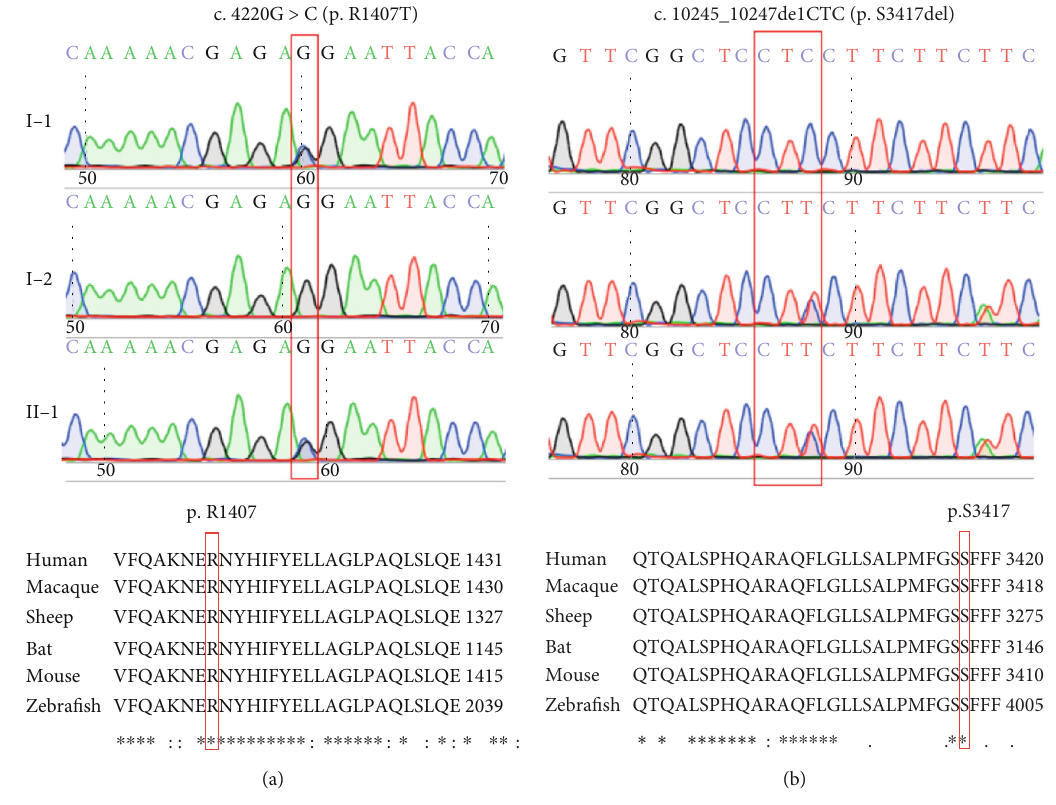
Figure 4: (a) The Sanger sequencing results of the p.S3417del and p.R1407T mutations in MYO15A in Family 2. (b) Multispecies sequence alignment of the S3417 and R1407 residues.